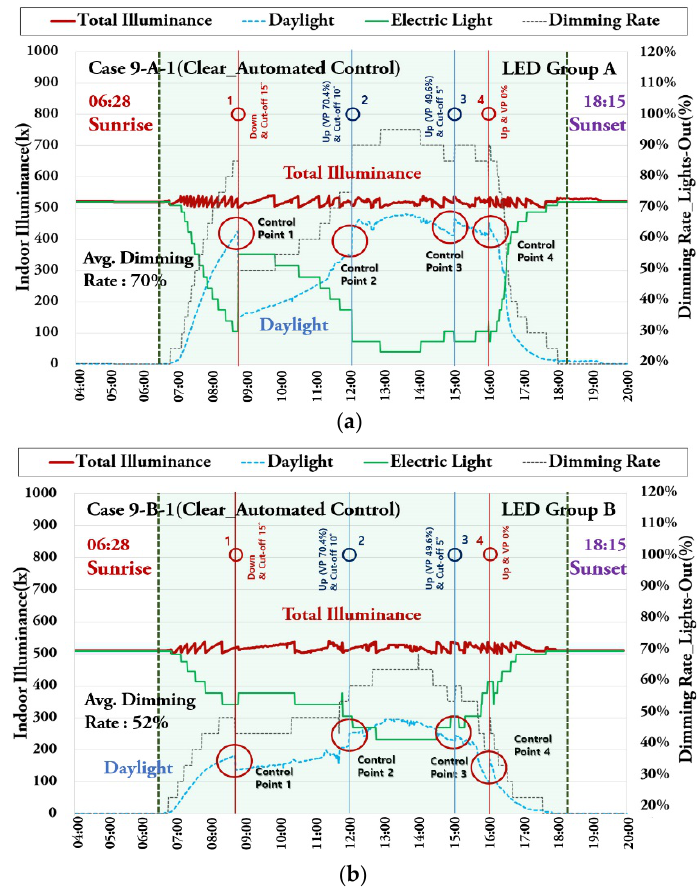
Figure 21. Illuminance and dimming rate under dimming control integrated with automatic blind control. (four steps, clear sky_10.02). ( a ) Case 9-A-1 and ( b ) Case 9-B-1 in Table 7.